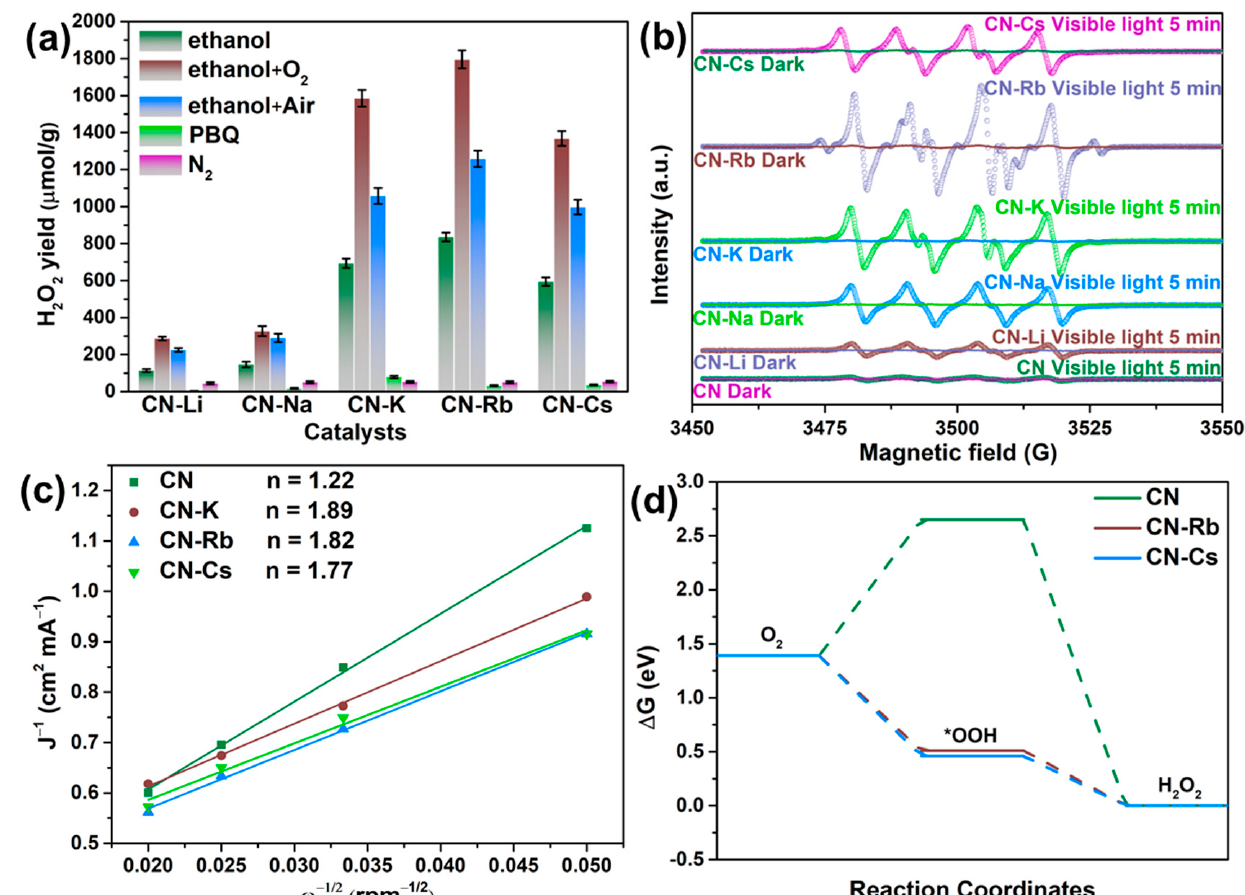
Figure 7. ( a ) Photocatalytic production of H 2 O 2 employing the modified PCN under various conditions. ( b ) Electron paramagnetic resonance signal of DMPO/ • OOH over the obtained PCN. ( c ) The average number of folds-transferred electrons (n). ( d ) The changes in the estimated Gibbs free energy of reduction of adsorbed O 2 to H 2 O 2 .